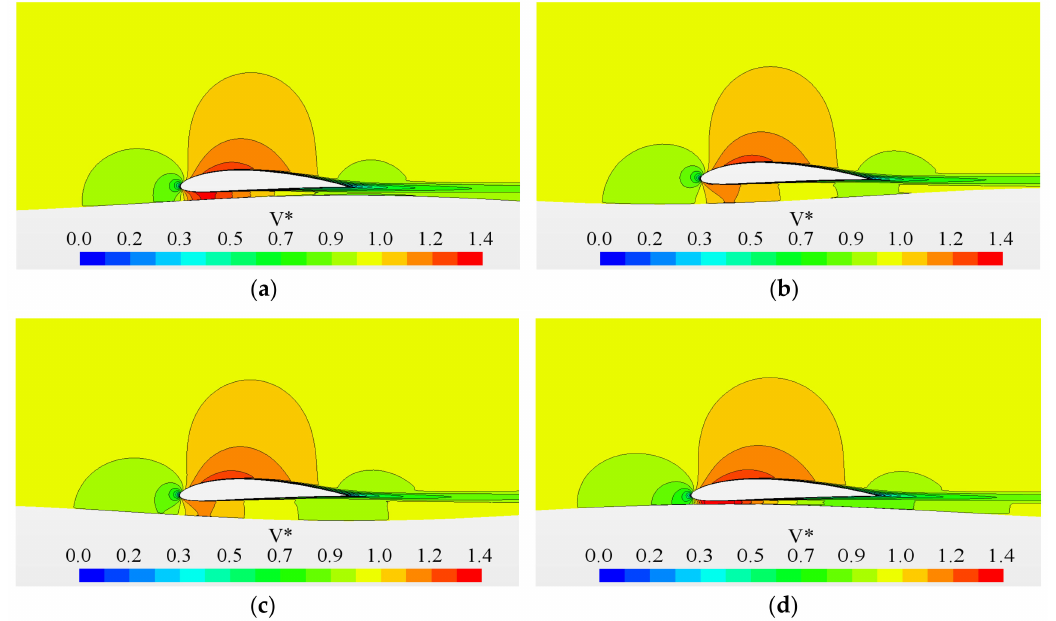
Figure 10. Velocity contours of di ff erent moments at α = 0 ◦ : ( a ) t* = 0.0, ( b ) t* = 0.25, ( c ) t* = 0.5, ( d ) t* = 0.84.